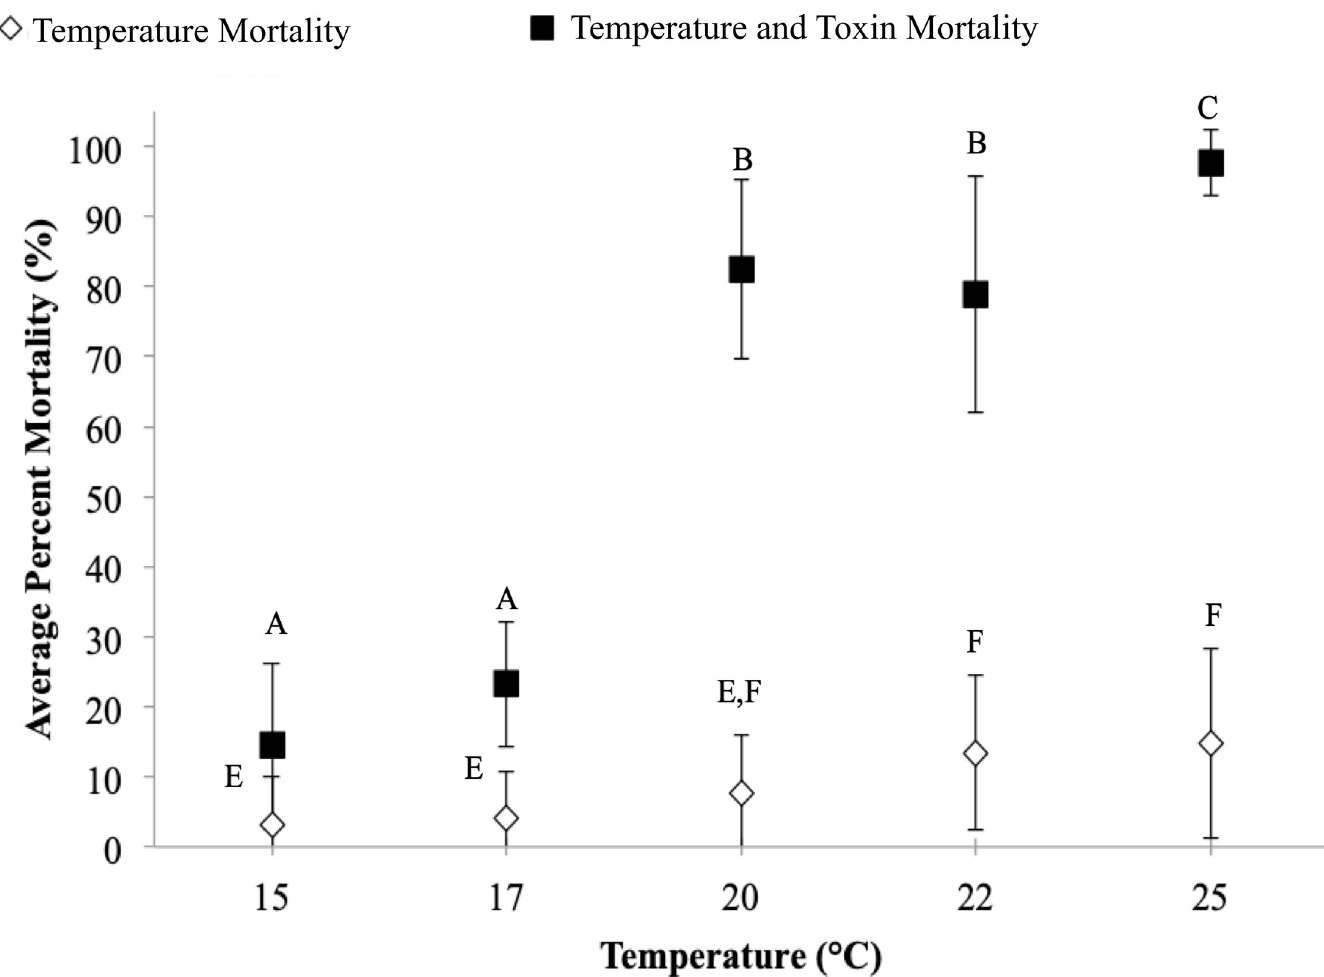
Fig 4. Temperature and microcystin-LR exposure from 15˚C-25˚C. Average percent mortality of B . longirostris collected in April 2017 over a range of temperatures when exposed to the LC 50 of 26.3 μ g L -1 microcystin-LR for 48-hrs. Temperature control treatments were without microcystin-LR. Error bars represent standard deviation. N = 9. Different letters indicate significant difference ( p < 0.05, Fisher’s LSD). ANCOVA: p < 0.0001. R 2 = 0.88. F = 0.21. p < 0.05. F 4 , 44 = 2.27. Temperature plus Toxin one-way ANOVA: R 2 = 0.90. p < 0.0001. F 4 , 41 = 85.37.